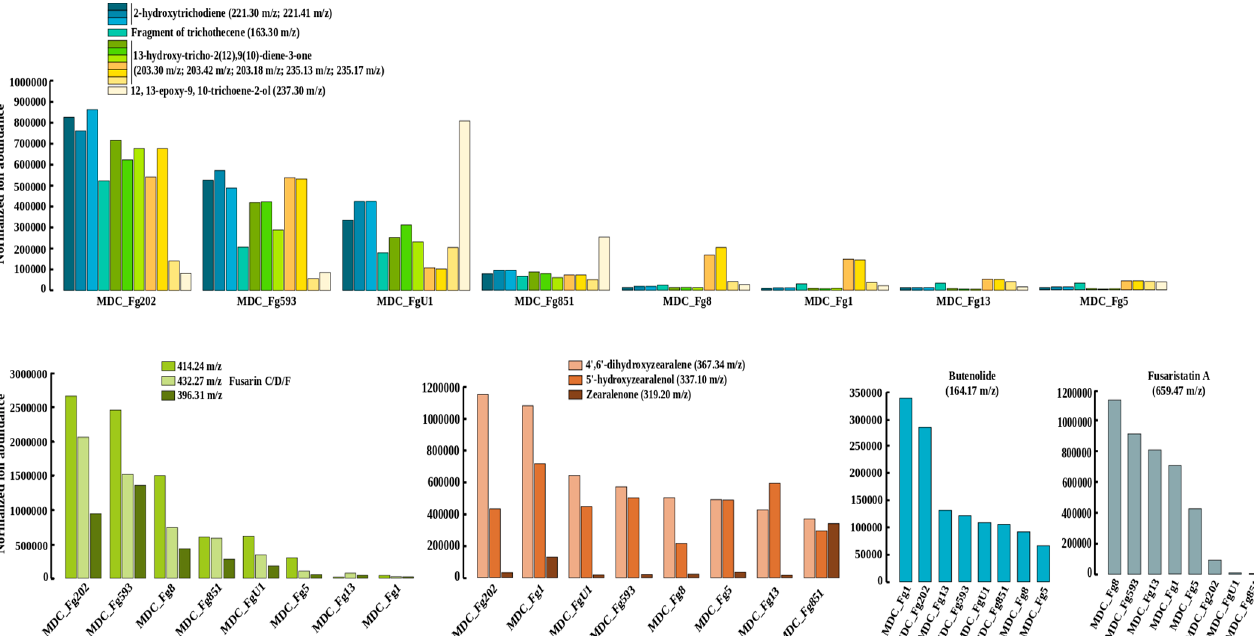
Figure 4. Abundances of selected metabolites in the eight F. graminearum strains. Ion abundances were derived from extracted ion chromatography (XIC) profiles obtained from mass spectrometry analysis (LC/MS) of the eight strains grown on PDA medium. Different detected ions corresponding to trichothecene biosynthesis (see Supplementary Figure S2 for details, mass-to- charge ratio ( m/z ): 163.30, 203.30, 203.42, 203.18 235.13, 235.17, 221.30, 221.41, 237.30), fusarin isoforms (retention time 19.8 min and m/z values of 396.31 for M-2xH2O+H, 414.24 for M-H2O+H, 432.27 for M + H), zearalenone and its intermediates (retention times 21.1, 23.5 and 34.3 min with m/z values of 319.20, 337.10, 367.34, respectively), Butenolide (retention time 2.9 min with m/z value of 164.17) and Fusaristatin A (retention time 27.9 min and m/z value of 659.47) are